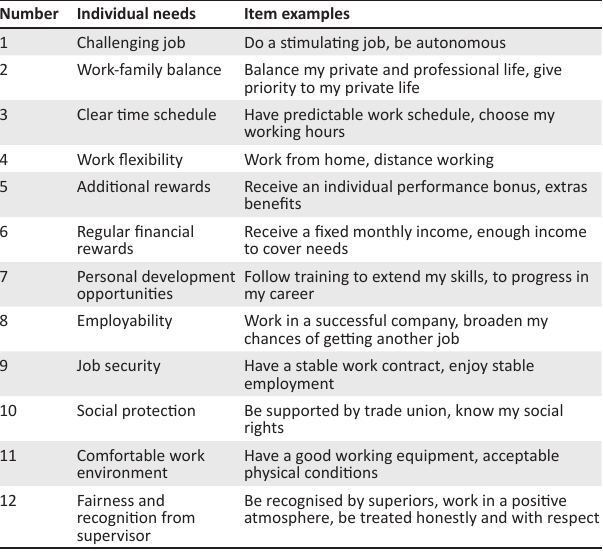
TABLE 2: Item examples for each specific needs-supplies fit